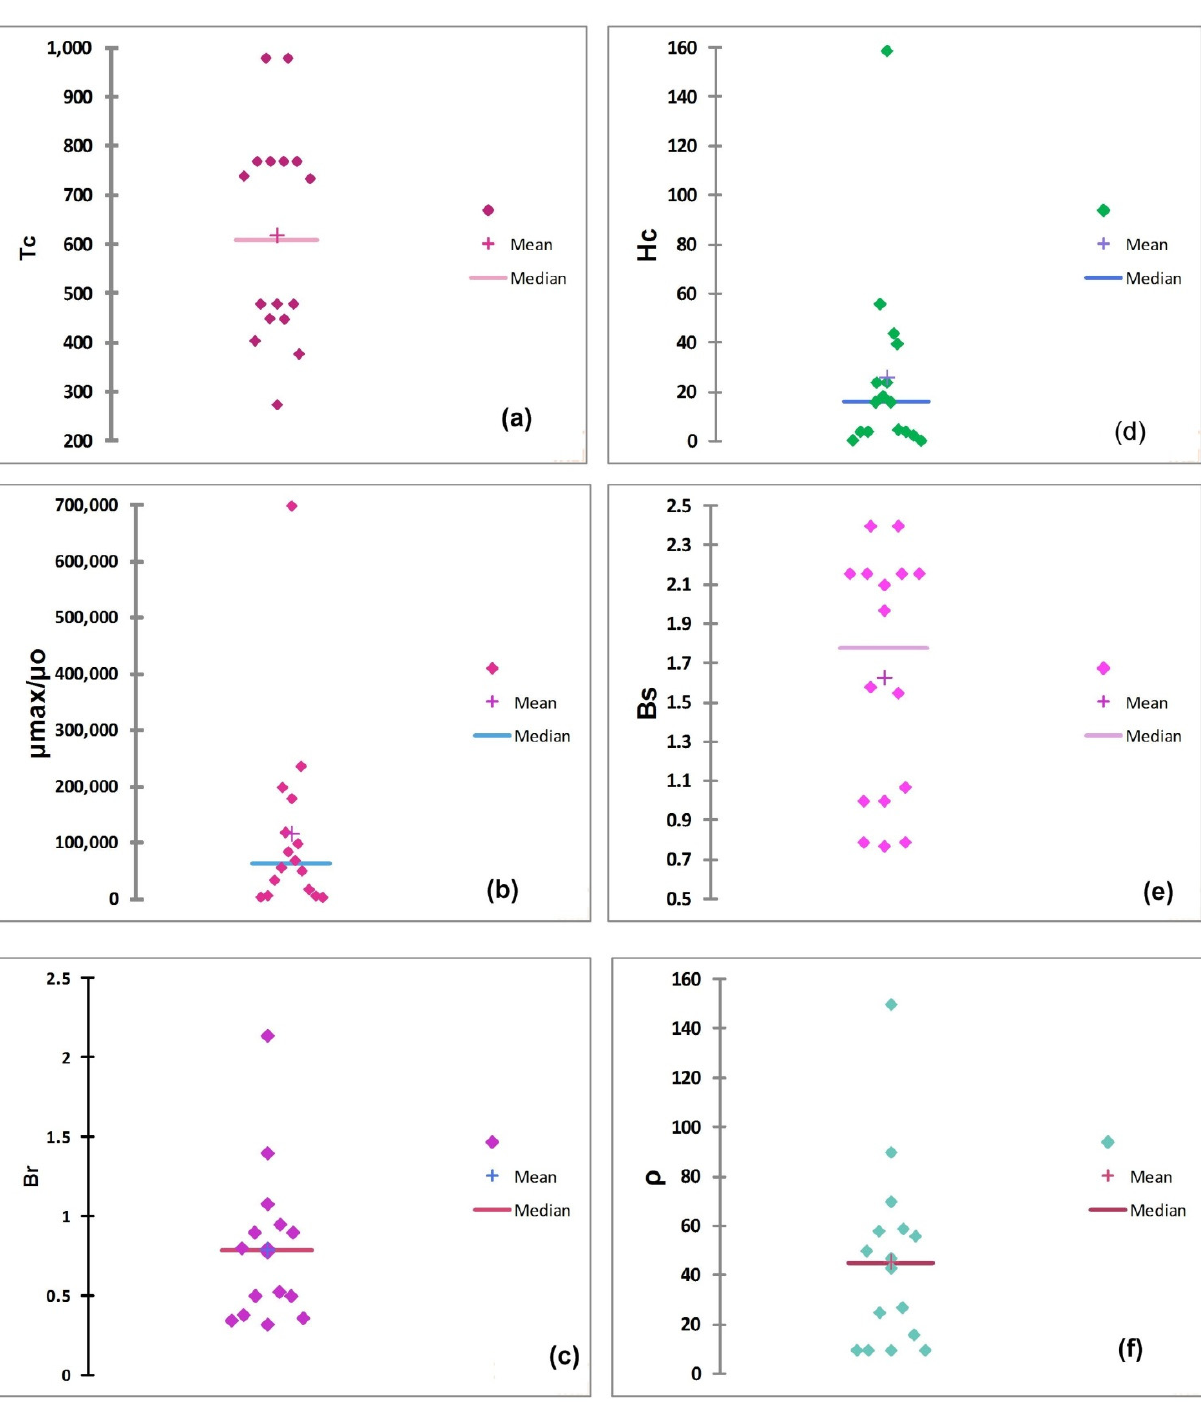
Figure 1. Descriptive data of ( a ) Tc, ( b ) μ max / μ o , ( c ) Br, ( d ) Hc, ( e ) Bs, ( f ) ρ , for enlisted soft magnetic materials.